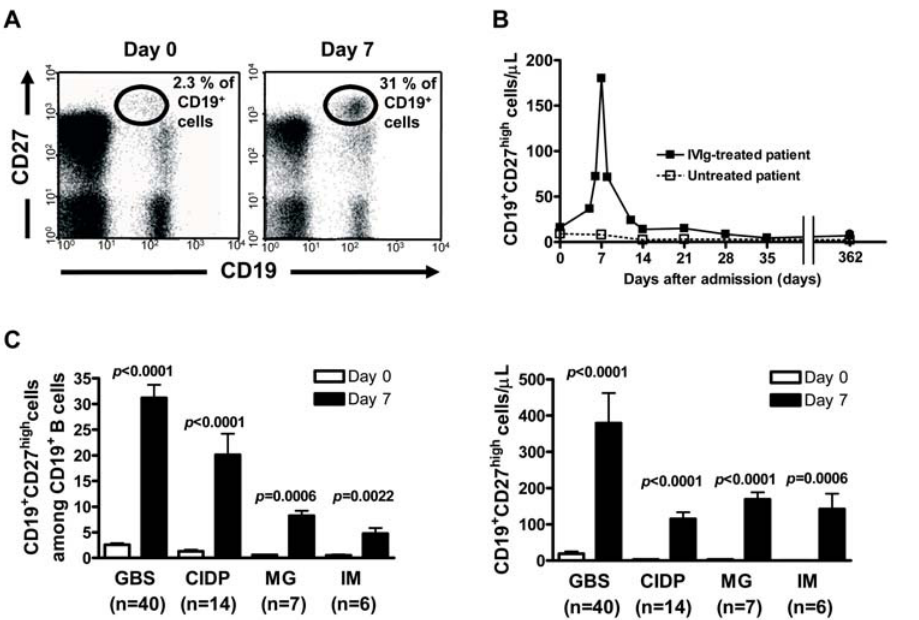
Figure 2. Prospective analysis of plasmacytosis in autoimmune patients. (A) Cytometric analysis of circulating CD19 + CD27 high plasma cells on day 0 and day 7 of IVIg treatment in a representative GBS patient. Proportions of CD19 + CD27 high plasma cells among CD19 + cells are indicated. (B) Peripheral CD19 + CD27 high plasma cell kinetics in representative GBS patients. (C) Proportions among CD19 + cells (left panel) and absolute numbers (right panel) of IVIg-mobilized CD19 + CD27 high plasma cells. GBS (disability grade 3 or more, n=40) and CIDP (n=14) patients received IVIg only, whereas MG (n=7) and IM (n=6) patients received IVIg and steroids. Data are mean 6 s.e.m. Mean values were compared using Mann-Whitney U test.